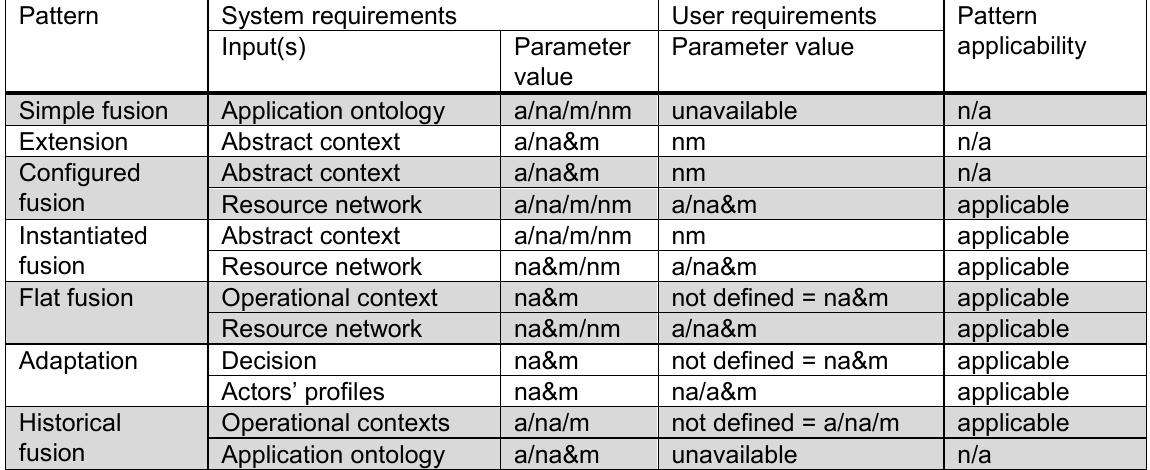
Table 9. Pattern-based